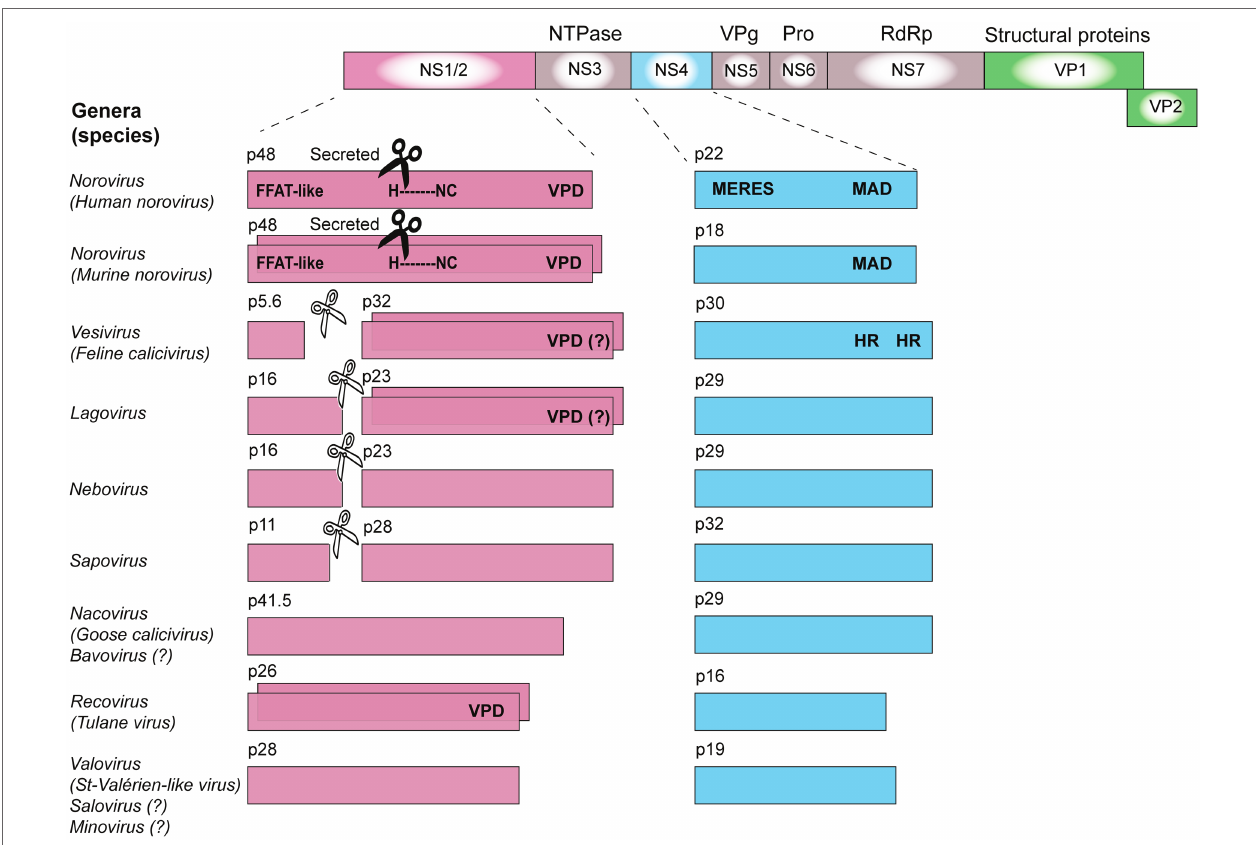
FIGURE 3 | Calicivirus non-structural protein processing, oligomerization, and domains. The coding sequences for non-structural proteins are shown in pink (NS1/2), blue (NS4), or gray (all other non-structural proteins), while coding sequences for structural proteins are shown in green (VP1 and VP2). The ability of some proteins to oligomerize is illustrated by staggered boxes. Black scissors indicate the presence of a caspase-3 cleavage site; white scissors indicate a viral 3C-like protease cleavage site. VPD, viroporin domain; HR, hydrophobic region; MAD, membrane-associated domain; H-NC, H-box and NC motif (asparagine-cysteine); MERES, mimic of an endoplasmic reticulum (ER) export signal; and FFAT, phenylalanine-phenylalanine acidic tract. Genes and gene products are drawn to